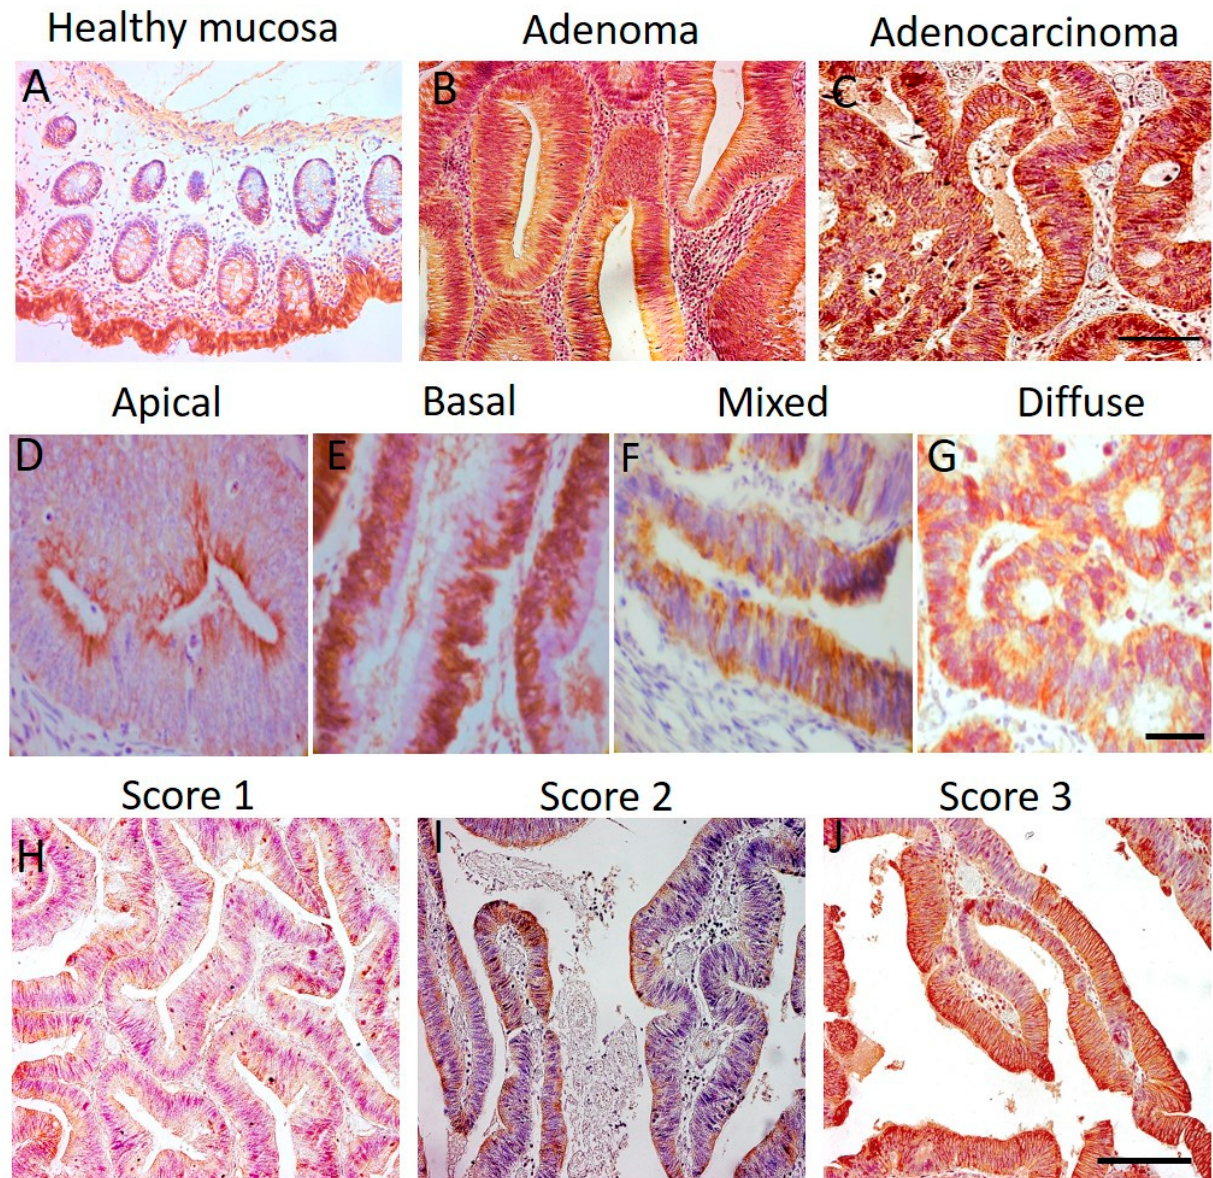
Figure 1. Expression of nNav1.5 protein in colorectal tissues. Immunohistochemistry was carried out using the polyclonal antibody, NESOpAb as described in Materials and Methods. In each picture, nuclei are counterstained in blue by haema- toxylin, since nNav1.5 is not present in this cell compartment. ( A ) healthy mucosa, ( B ) adenoma, ( C ) adenocarcinoma. Scale bar: 100 µ m. ( D – G ) Representative micrographs of adenocarcinomas showing different staining patterns: apical ( D ), basal ( E ), mixed ( F ) and diffuse/all-over ( G ). Scale bar: 50 µ m. ( H – J ) Adenocarcinomas with different scores (1 to 3). Scale bar: 100 µ m.